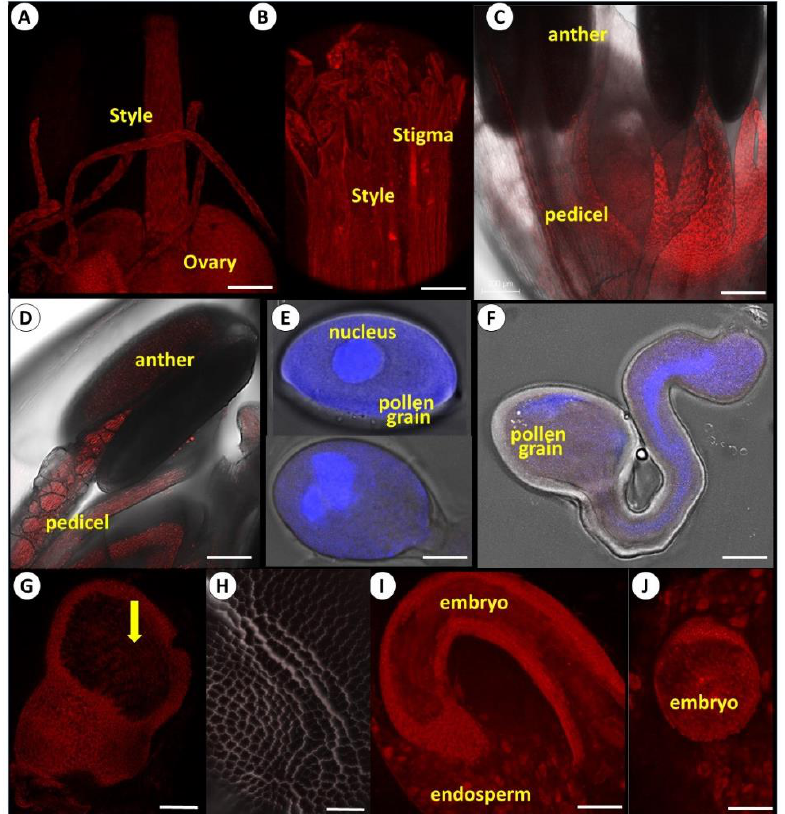
Figure 5. Representative confocal microscopy images of FISH tracing potyviruses’ spatial distribution in reproductive tissues and seeds of fertile garlic. Virus RNA was labeled by Cy-3. Pollen in E and F are stained with DAPI in addition to Cy-3. Scale: A, C, D, G, H, I = 250 µm; B = 50 µm; E, F = 10 µm; J = 150 µm. ( A ) Female flower organs, ovaries, style, and stigma. ( B ) Close-up of style, stigma, and papilla. A strong signal was recorded. ( C ) Male organs of garlic flower. The filaments are infected, while no signal is visible in the anthers. ( D ) Close-up shot of the anther. ( E ) Pollen grains before and after germination; vegetative and generative nucleus cells are colored by DAPI, and no signal from potyviruses is recorded. ( F ) Pollen tubes. Vegetative and generative nuclei cells are colored by DAPI. No signal from potyviruses is recorded. ( G ) Seed developing inside an ovary. ( H ) Seed coat, no visible signal. ( I ) Longitudinal section of viable seed before germination. Both embryo and endosperm are infected with potyviruses. ( J ) Cross-section of seed.